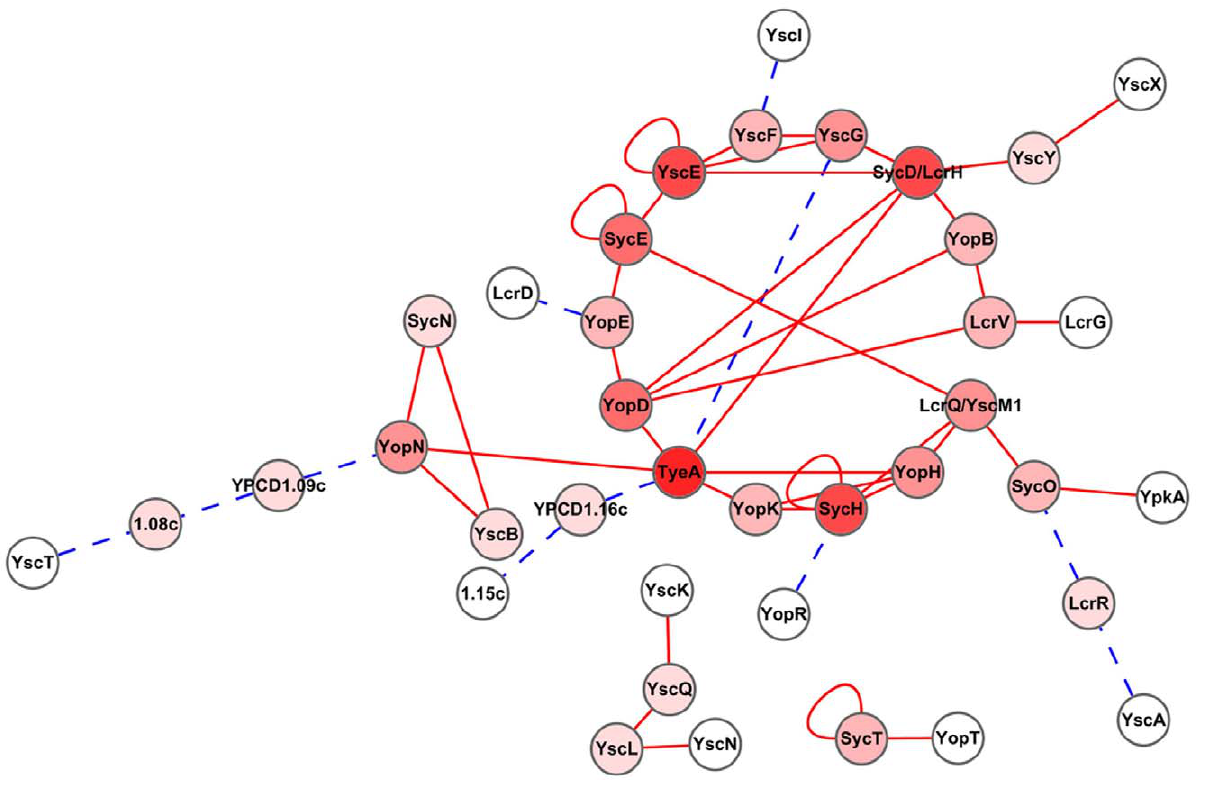
Figure 3. Graphic view of the protein-protein interaction network of Yersinia T3SS. The graphic view of the network was drawn using Cytoscape 2.0 software [47]. All the functionally well characterized interactions among Yersinia type III secretion apparatus components and the potential novel interactions identified in this study were included. The darker colors indicate the higher centrality of a protein in this network. Red lines indicate known interactions that had been reported and functionally validated by biochemical methods. Blue and dotted lines indicate novel interactions identified by our yeast mating assays.